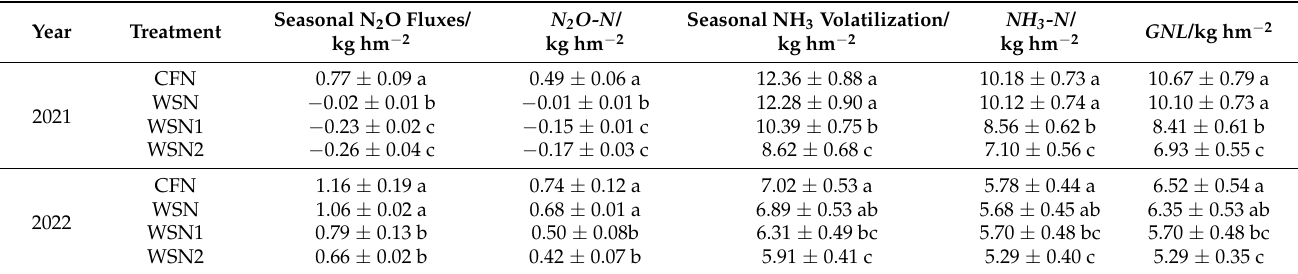
Table 2. Gaseous nitrogen losses during the rice cropping season.